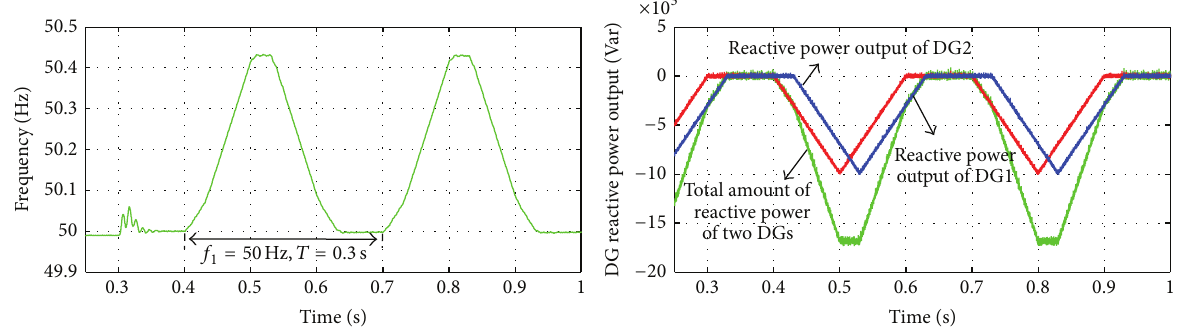
Figure 11: The PCC frequency and the separate and total reactive power output of both DGs in the second